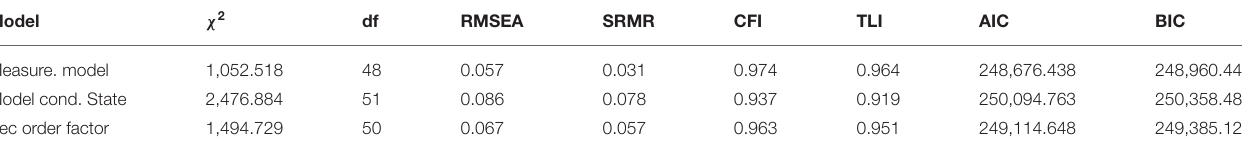
TABLE 4 | Fit indicators for the assessed